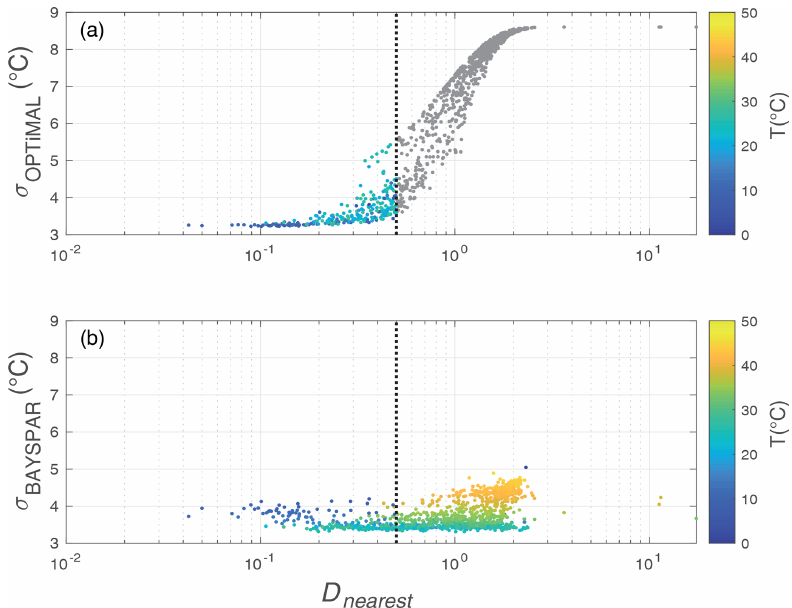
Figure 14. Inter-comparison of temperature estimates and standard errors ( y axis) for compiled Eocene and Cretaceous data calculated using OPTiMAL (a) and BAYSPAR (b) . Greyed-out data fails the D nearest test ( > 0.5), and the colour scaling reflects D nearest values for those data points that pass. The black dashed line shows the D nearest threshold ( >